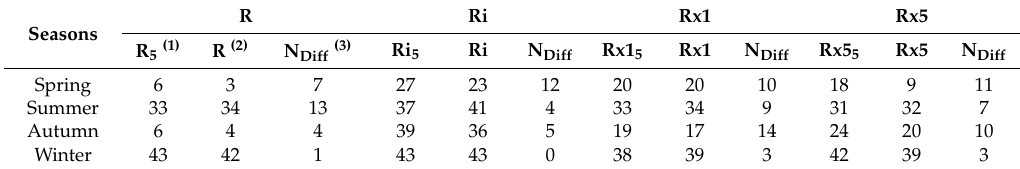
Figure 4. Trends of the 5 ‐ year return levels for the four precipitation indices. ( a – d ) changing trends for R 5 in spring, summer, autumn and winter, respectively, and similarly the ( e – p ) shows the trends for the Ri 5 , Rx1 5 and Rx5 5 in the four seasons. The “+” and “ − ” represent increasing and decreasing trends respectively, and the black circle indicate significance at p < 0.05. Table 4. Numbers of stations that had increasing primary precipitation indices and had increasing 5 ‐ year return levels, and numbers of the stations that had different trend directions in initial indices and 5 ‐ year return levels in different seasons.